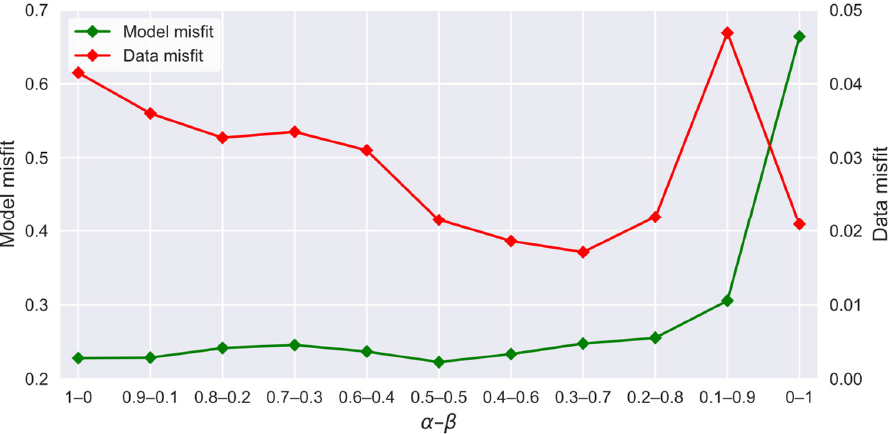
Figure 8. Comparison of the effect of different weighted parameter pairs ( α − β ) on PhyDNN inversion. α and β denote the weighted parameters of model misfit term and data misfit term, respectively, which sum to 1. The left and right y-axes plot the model misfit and data misfit sepa- rately.